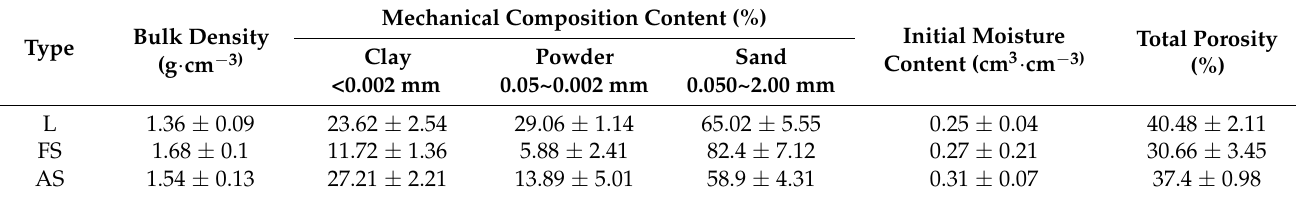
Table 1. Basic physical properties of the filled soil